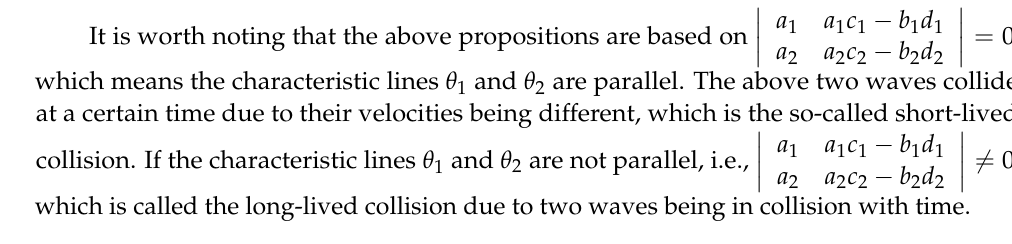
Figure 9. (Color online) The transformation of two-breather with r 2 = r 3 = r 4 = r 6 = r 7 = r 8 = 1, β 1 = β 3 = 2, κ 1 = κ 2 = 0. In ( a ), a 1 = 0.3, b 1 = 1, c 1 = 1.2, d 1 = 0, e 1 = 1, f 1 = 1, γ 1 = − 10, a 2 = 0.2, b 2 = 0, c 2 = 1.2, d 2 = 1, e 2 = 2 , f 2 = 2 , γ 2 = 10. In ( d ), a 1 = 0.04, b 1 = 0.2, c 1 = 0.5, d 1 = 0, 3 3 e 1 = − 0.01, f 1 = 1, γ 1 = 5, a 2 = 0.2, b 2 = 0, c 2 = 0.5, d 2 = 1, e 2 = − 0.005, f 2 = 1, γ 2 = 0. These two figures are three-dimensional stereograms of two-breather transformation when t = 0, z = 0. ( b , e ) are the corresponding contour figure. ( c , f ) show the wave moves along the x axis when y = − 50, t = 0, z =